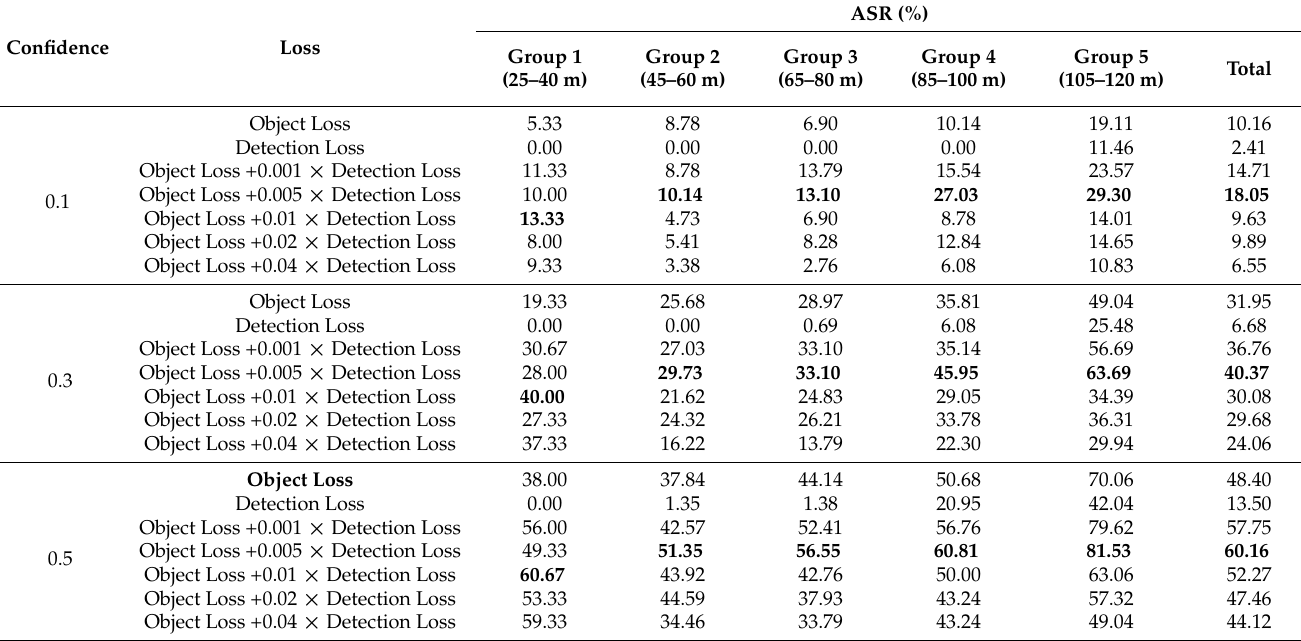
Table 6. Experimental results of different loss items for Yolo-V5. Bold fonts indicate the best effect.